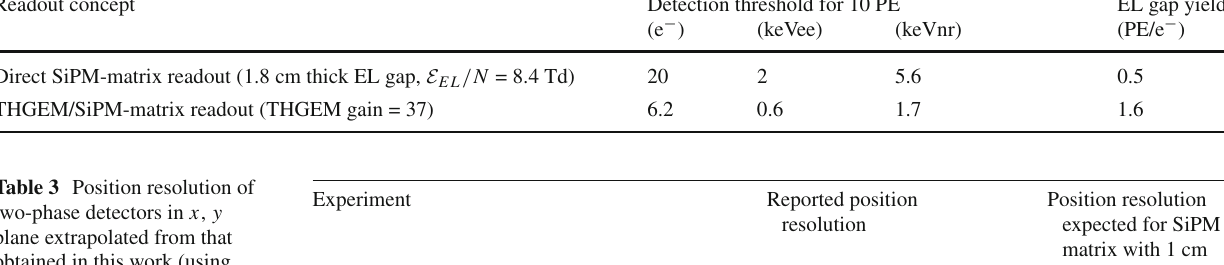
Table 2 Detection thresholds, corresponding to 10 PE signal at the SiPM matrix, that can be achieved under optimal conditions for alter- native readout concepts of the two-phase argon detectors with 1.8 cm thick EL gap, expressed in drifting electrons in the EL gap ( e − ) and in Readout concept Detection threshold for 10 PE